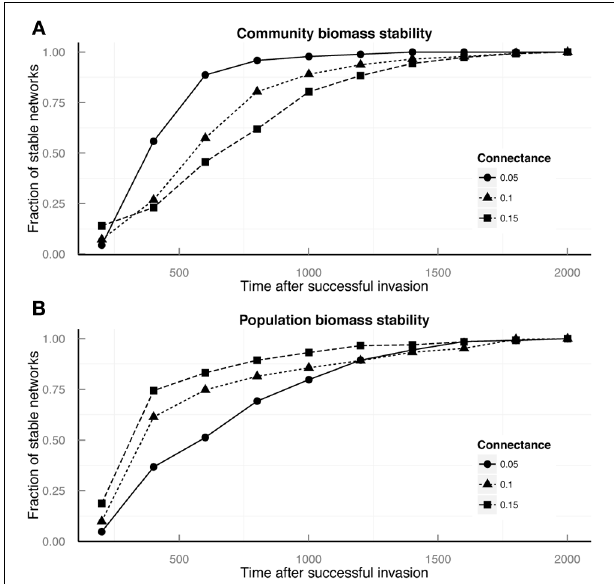
FIGURE 4 | Food web stability analysis for communities with successful invasions. Cumulative fraction of stable networks is presented in terms of (A) total community biomass, and (B) mean species biomass CV, plotted against the time elapsed since the invasion. Circles, triangles, and squares represent the fraction of communities achieving stability at that time step for communities with connectance values of 0.05, 0.1, and 0.15